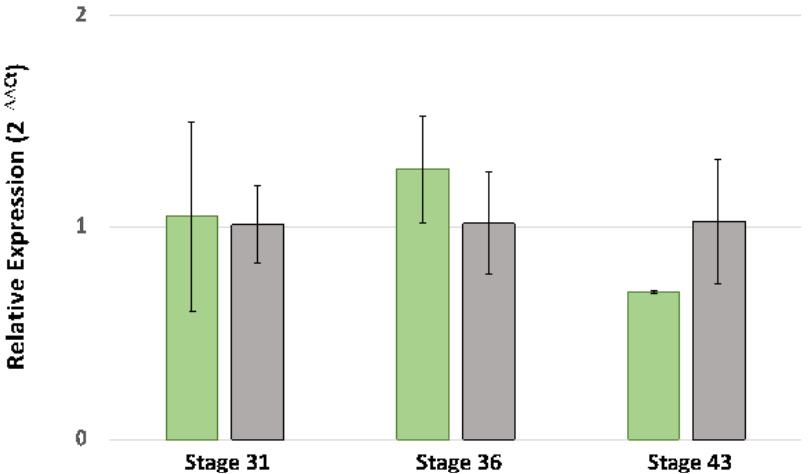
Figure 6. Quantitative PCR analysis of Ltk gene expression in A. mexicanum embryos (N = 3 wild- type and 3 melanoid embryos per stage). Green bars correspond to wild-type embryos; gray bars correspond to melanoid embryos. The error bars are standard deviations of relative fold expression. Ltk gene expression was not statistically different between wild-type and melanoid embryos for any of the stages ( t -test p > 0.05).